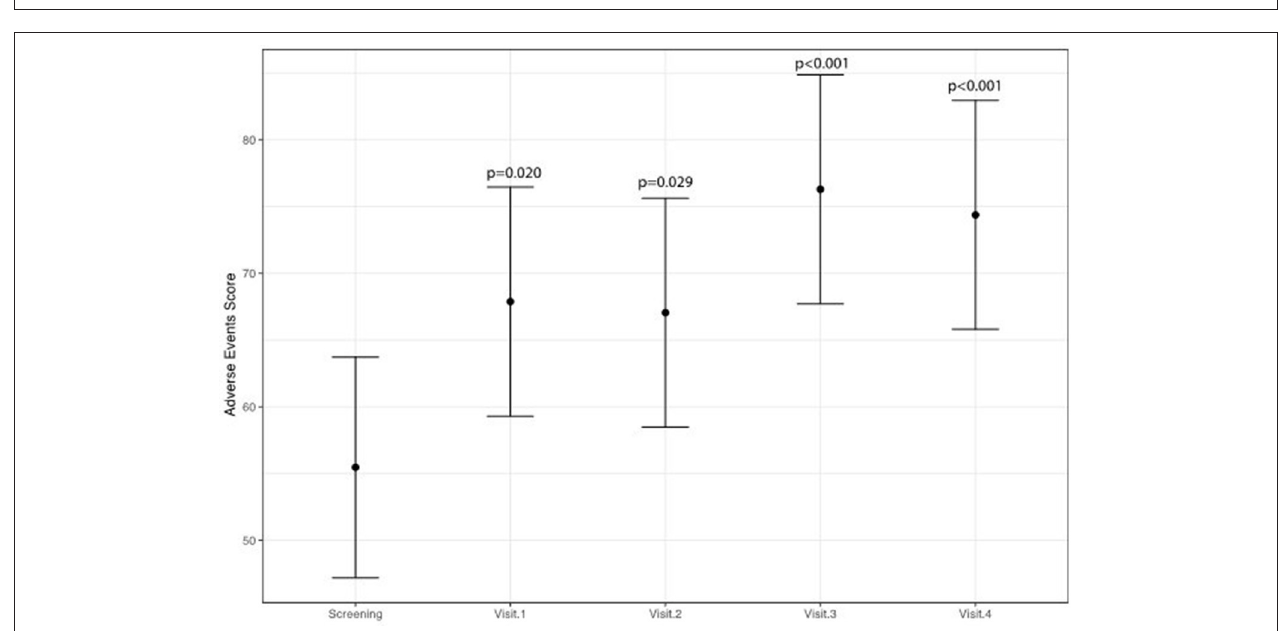
FIGURE 3 | Variation of adverse events of anti-angiogenetic treatment levels (higher scores indicate less adverse